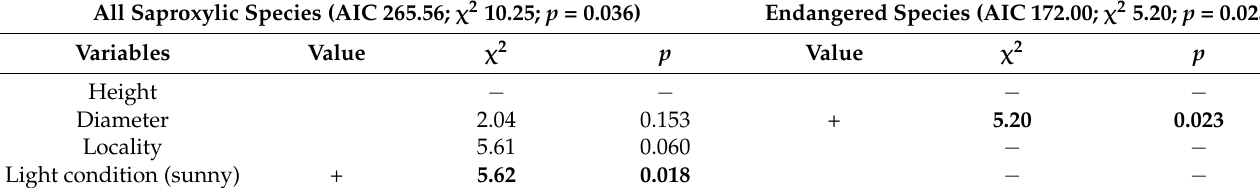
Table 1. Species richness of saproxylic beetles in the study location. Stepwise (the lowest AIC) generalized linear model (Poisson distribution) was used. Results of whole model are with the name of dependent variables and estimate of variables in model are shown below. Value (+) corresponded to positive result of variable. Omitted variables during the process of stepwise model are marked ( − ). Statistically significant effects are marked in bold.